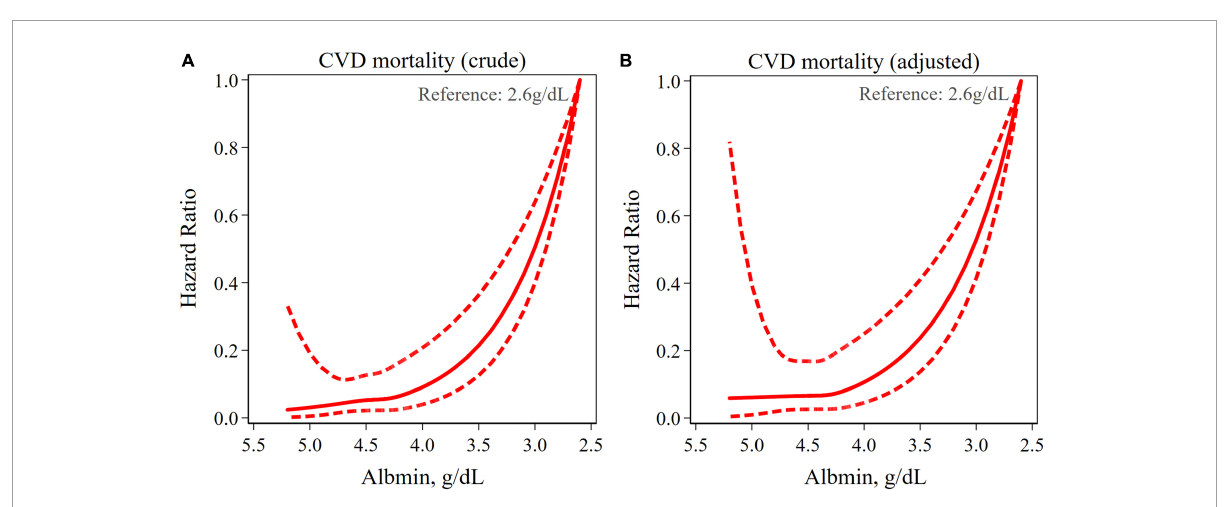
FIGURE3 Restricted cubic spline (RCS) curves for analyzing the non-linear association between albumin levels and cardiovascular disease (CVD) mortality. Same variables adjusted as Table 2